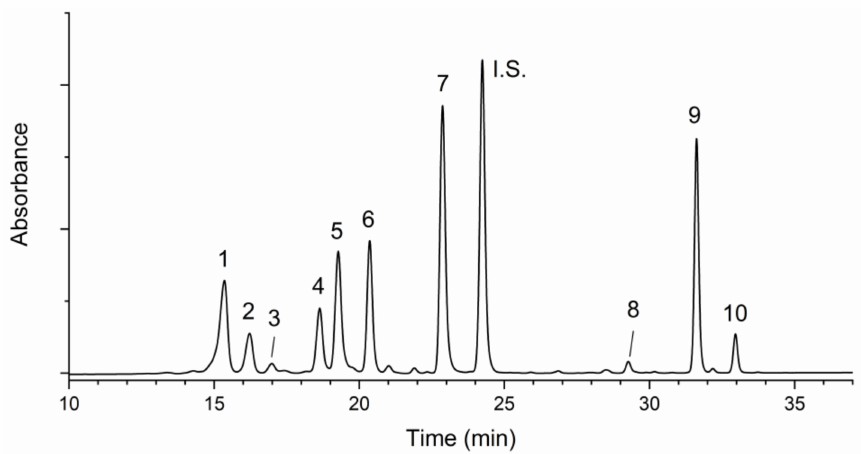
Figure 6. Typical chromatogram of carotenoids extracted from a microgreen sample of Lactuca sativa L. Group crispa (cultivar ‘Bionda da taglio’). For chromatographic and detection conditions, please see Section 2.8 in the text. 1, violaxanthin; 2, neoxanthin; 3, lutheoxanhin; 4, lactucaxanthin; 5, chlorophyll b; 6, lutein; 7, chlorophyll a; I.S., internal standard; 8, cis-13- β - carotene; 9, β -carotene; 10, cis-9- β